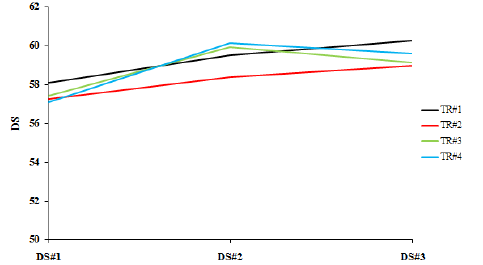
Figure 4. Evolution of DS over each TR for HMPE#1.